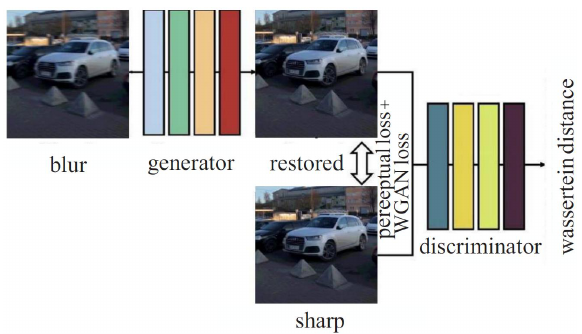
Fig. 2. The basic framework of